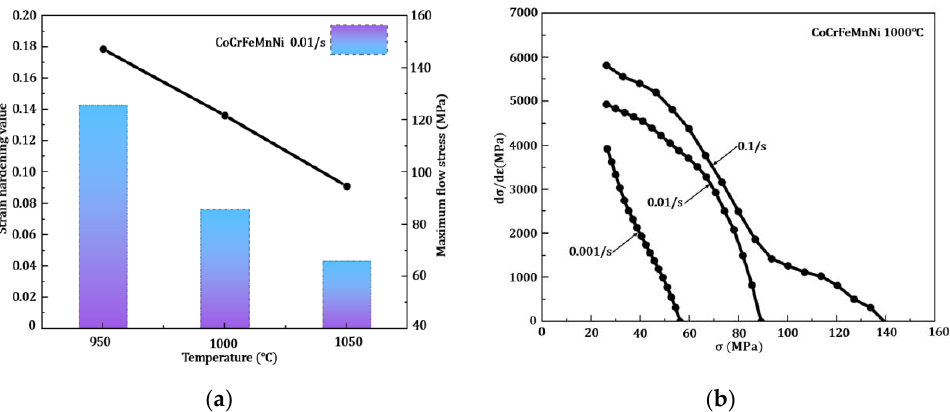
Figure 4. Hardening performance of the CoCrFeMnNi: ( a ) strain hardening component, n , ( b ) the hardening rate at 1000 °C (0.001/s, 0.01/s and 0.1/s).